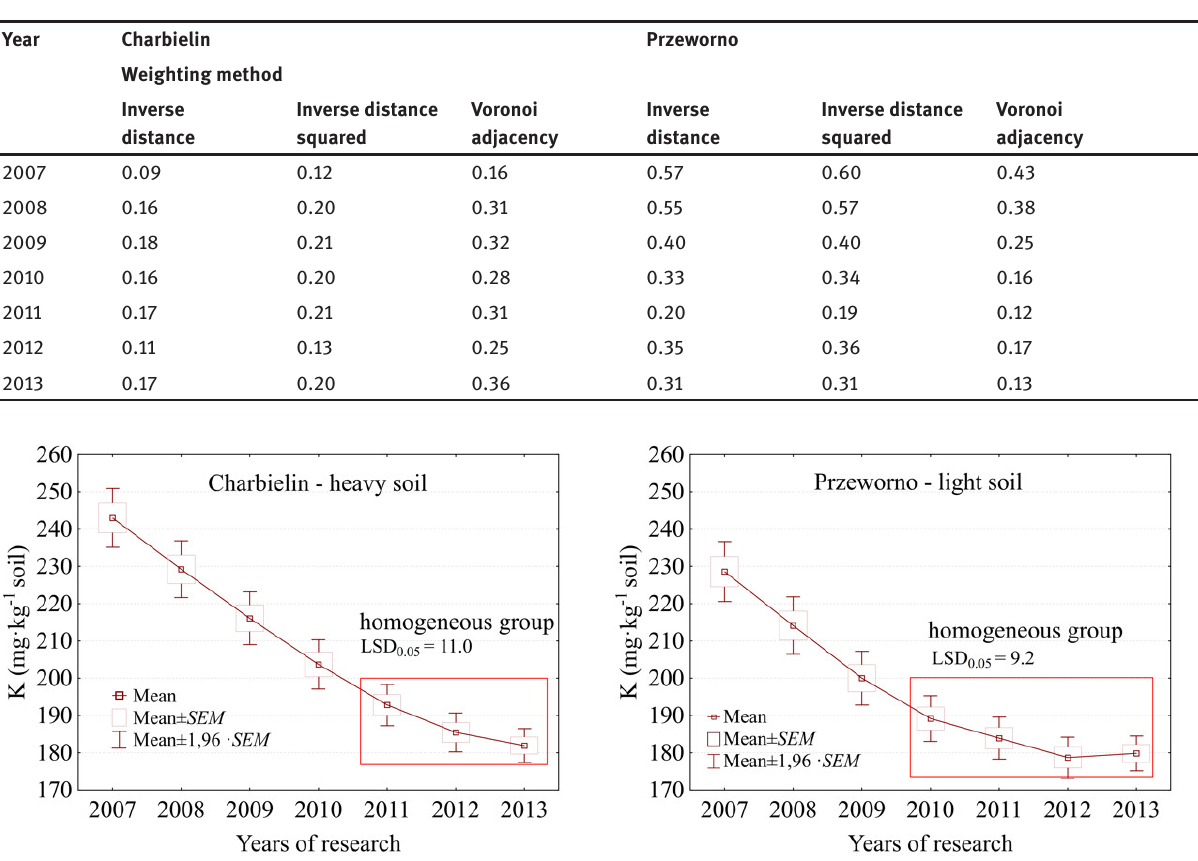
Table 7: Spatial autocorrelation − Moran’s I